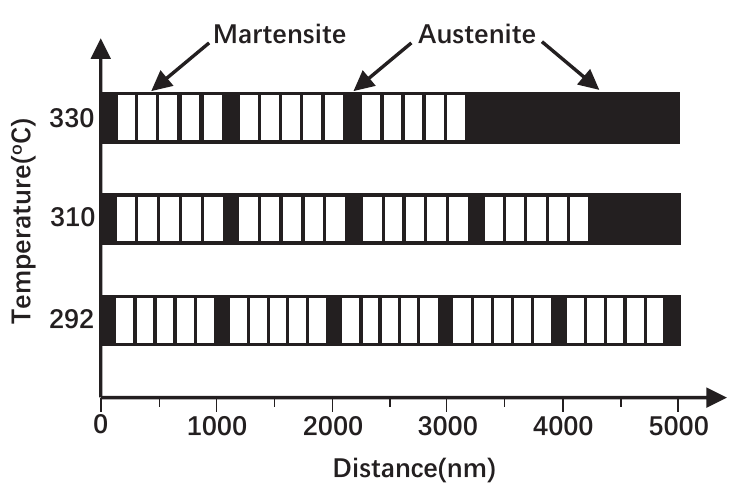
Figure 1. Schematic illustration of lath martensite, film-like, and blocky austenite distribution in modeling